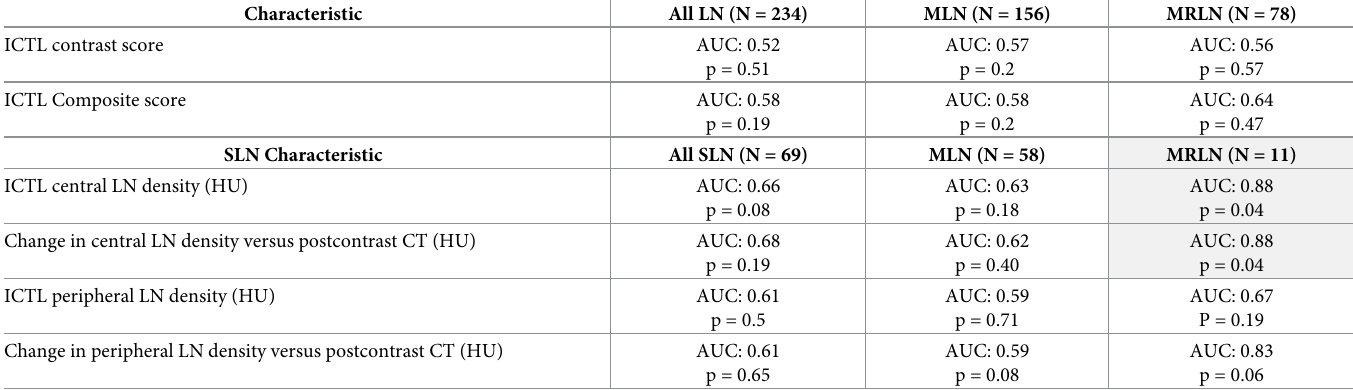
Table 8. Significance of logistic regression model and receiver operator characteristic curve analysis for imaging features of the ICTL to predict lymph node (LN) metastasis in 69 identified sentinel lymph nodes in 38 dogs a .